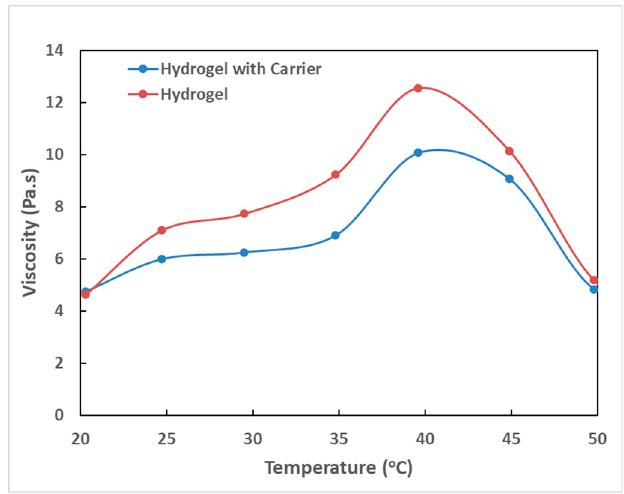
Figure 6. Analysis of the fluid viscosity of the hydrogel before and after mixing with IMQ-containing liposomes.